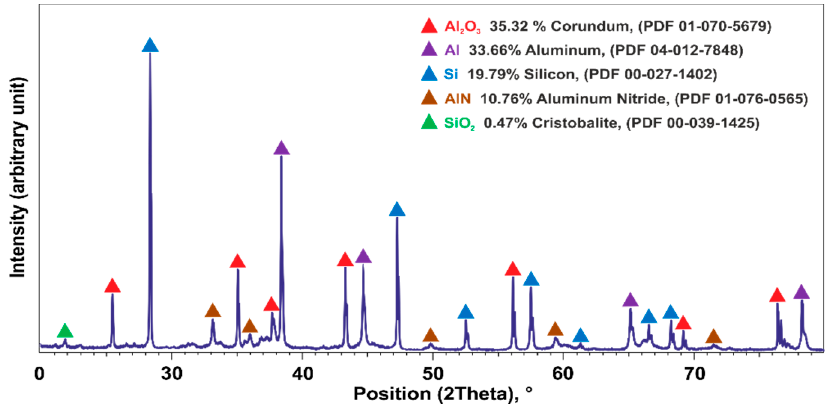
Figure 3. XRD pattern of the fine dross (<1 mm) that contains non-metallic components. Table 2. Chemical composition of HCFeMn slag by XRF